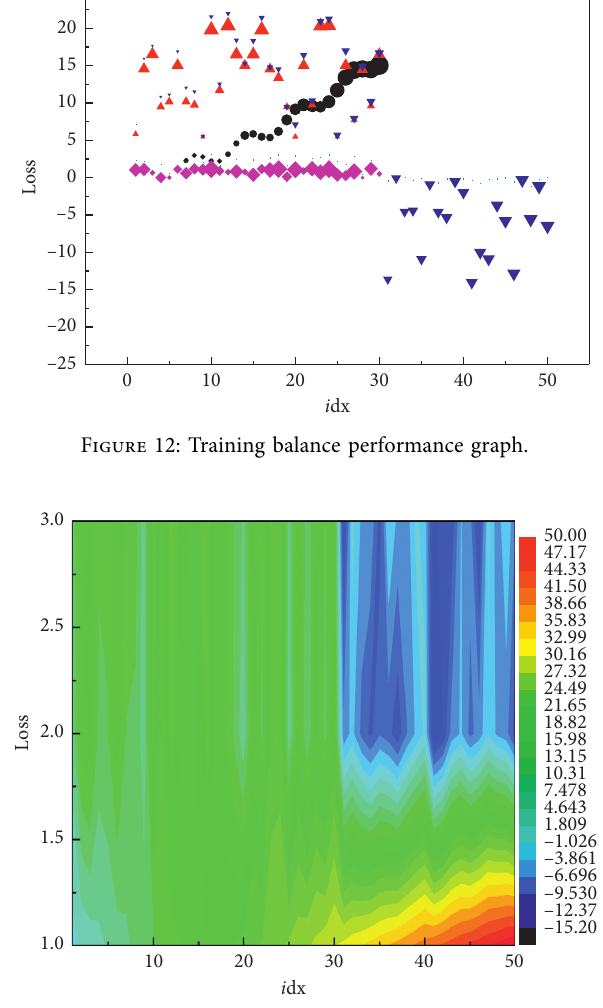
Figure 13: The gradient disappears and pulls